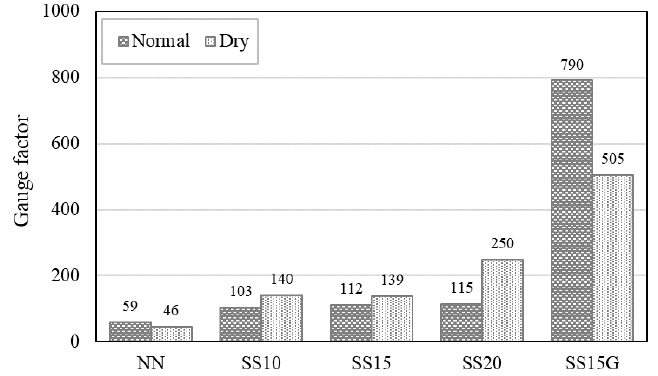
Figure 13. Comparison of gauge factor of concrete with steelmaking slag.